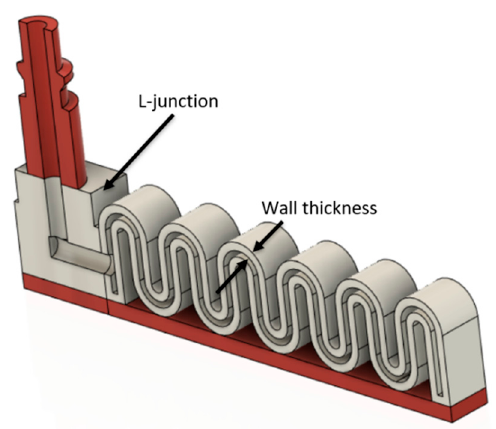
Figure 9. Cross section of S-type.